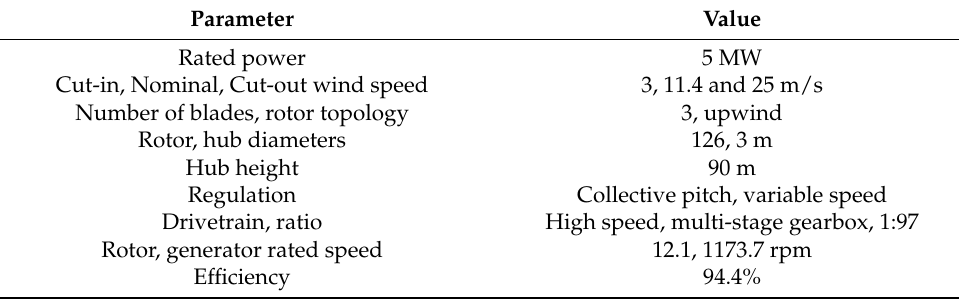
Table 1. NREL 5 MW most relevant specifications